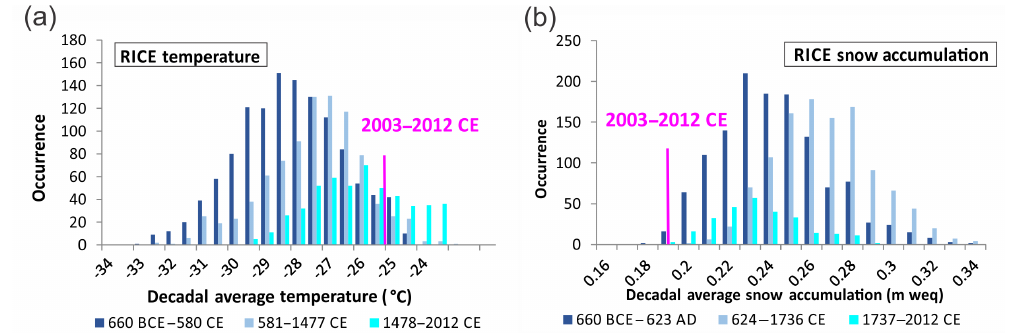
Figure 7. (a) Frequency occurrences of decadal temperature variations (10-year moving averages) as reconstructed from the RICE ice core are shown for three periods: 660BCE to 580CE – dark blue; 581–1477CE – light blue; and 1478–2012CE – cyan. The 10-year average temperature for the most recent decade contained in the record (2002–2012, − 25.78 ◦ C) is shown in pink. (b) Frequency occurrences of decadal RICE snow accumulation variations: 10-year moving averages for 660 to 623CE (dark blue), 624–1736CE (light blue) and 1737– 2012CE (cyan). The 10-year average for the most recent decade contained in the record (2002–2012, 0.2mw.e.) is shown in pink.